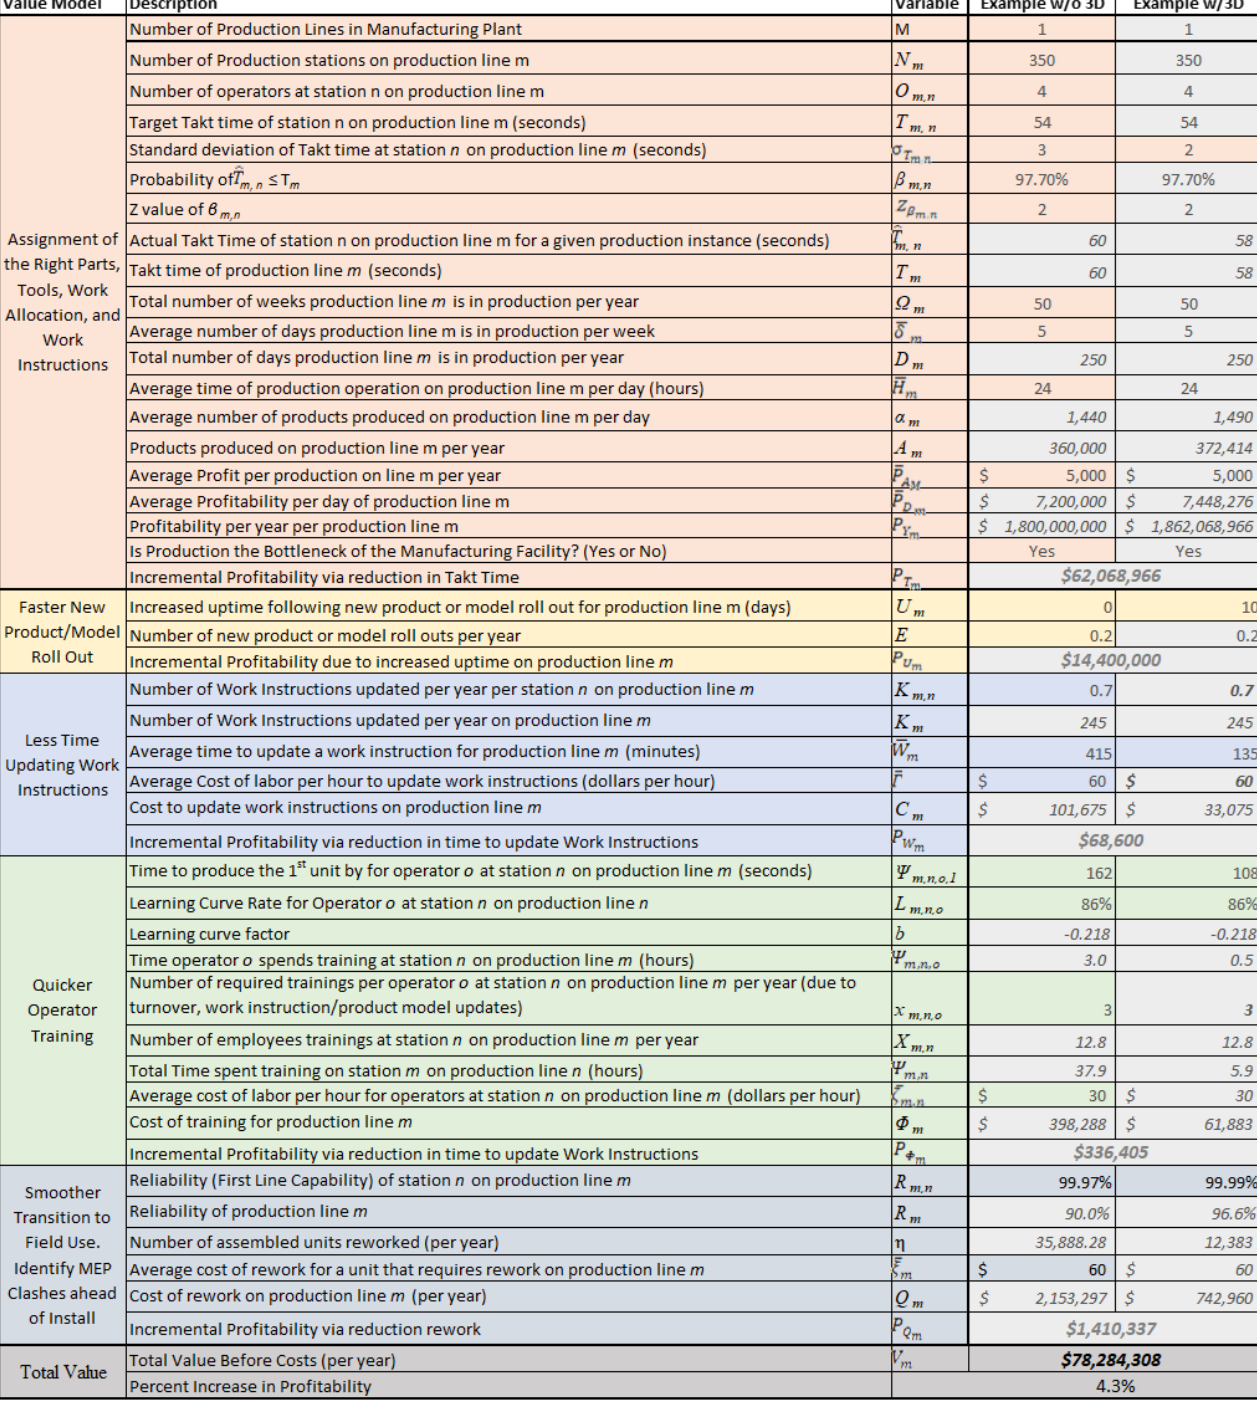
Figure 3. The 3D Product Model Value in Production Process – Quantitative Model Input Sheet with Values.